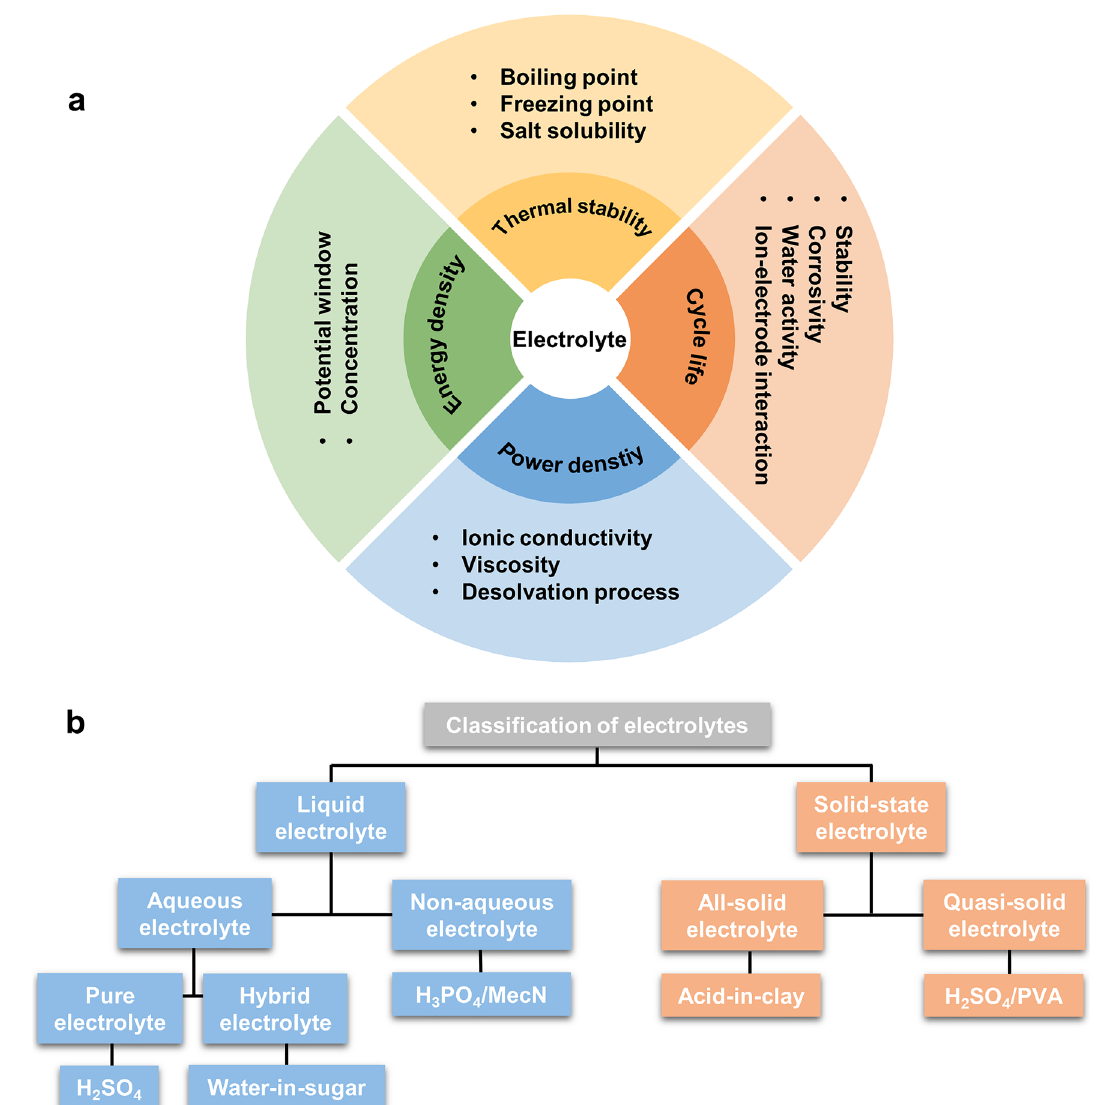
Fig. 5 a Physicochemical and electrochemical effects of electrolytes on proton batteries. b Classification of electrolytes for proton